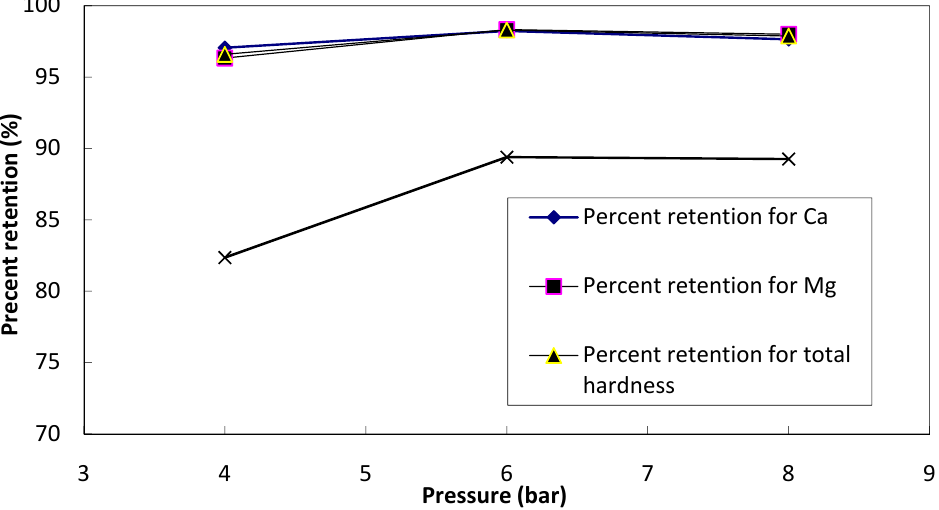
Figure 5. Retention of Ca 2+ , Mg 2+ , total hardness and TDS vs . pressure for Sample